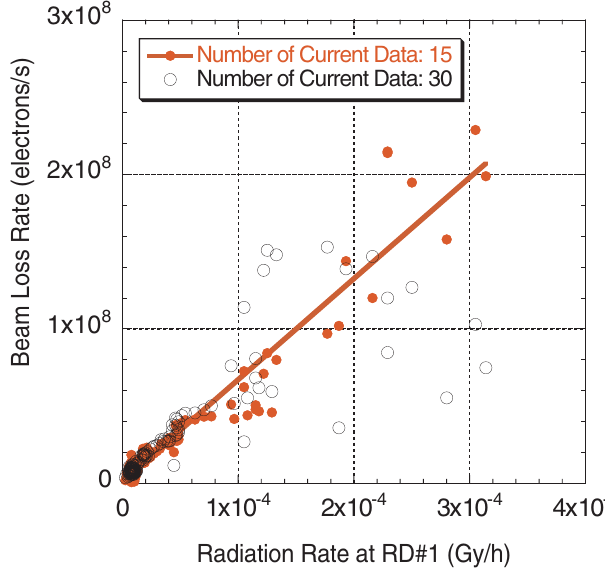
FIG. 7. (Color) Correlation between the beam loss rate and the (cid:1) -ray intensity at RD#1. A good proportion is confirmed by the plot of the red closed circles, where the beam loss rate was calculated with a smaller number (15, usually 30) of current data in order to reduce time lags in the regime where the beam loss rate changed rapidly. The black open circles are additionally plotted using the same data as those in Fig. 6; the proportional relation appears worse due to large time